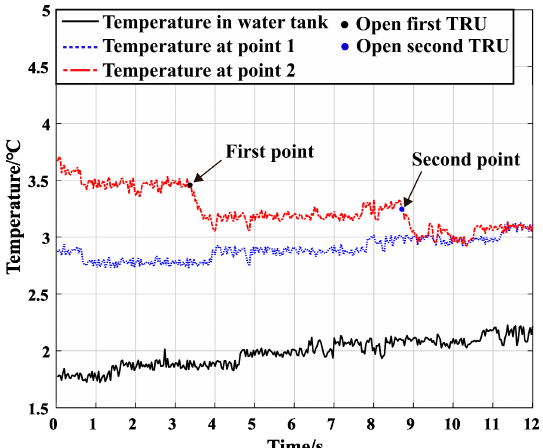
Figure 19. Temperature change of opening thermoelectrical refrigeration units.